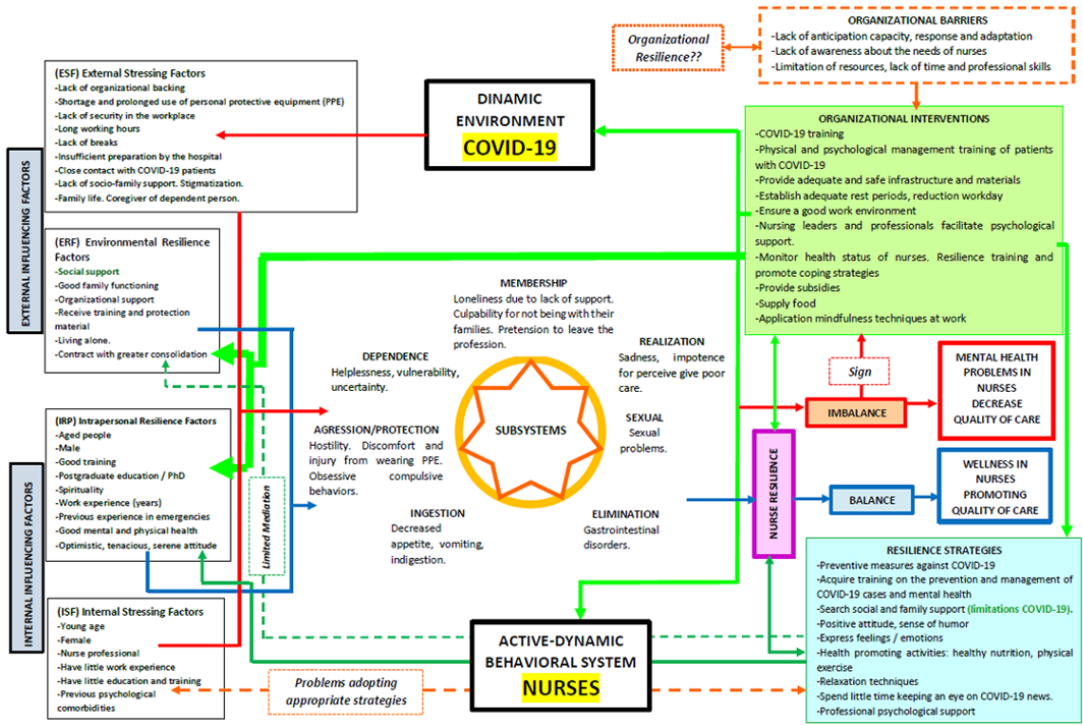
Figure 2. Intrapersonal resilience factors, environmental resilience factors, and other factors